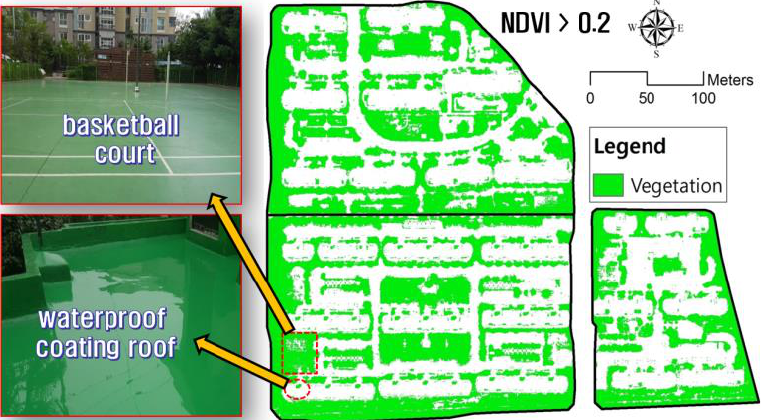
Figure 12. Vegetation map classified by applying NDVI around trees and grass lands.